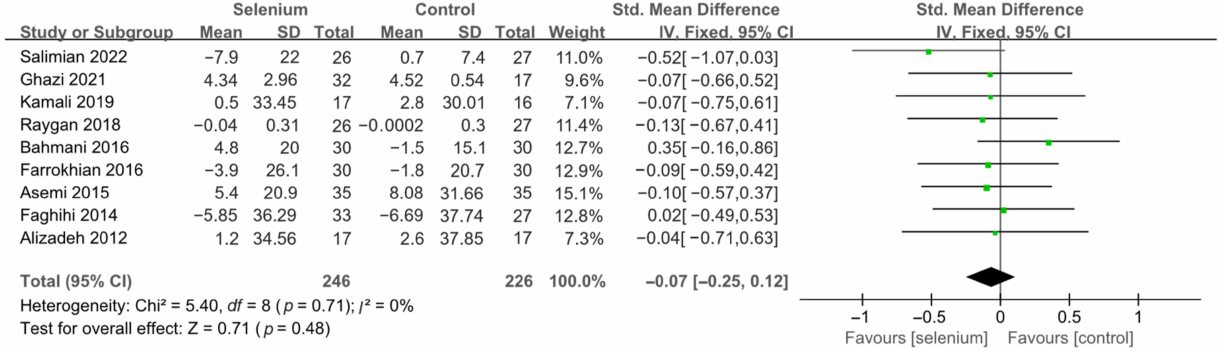
Figure 9. Forest plot of TC